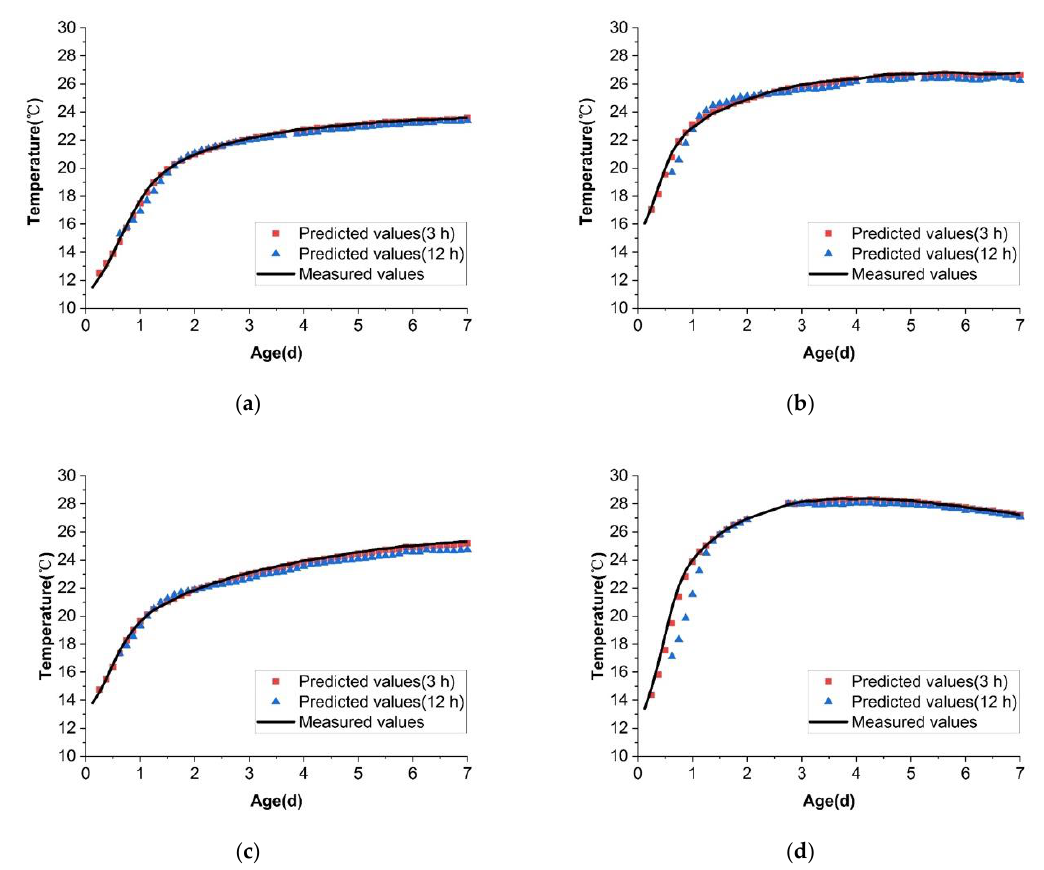
Figure 8. Comparisons of predicted and measured temperature for Wudongde dam: ( a – d ) the predicted and measured values of the four old concrete blocks, respectively.